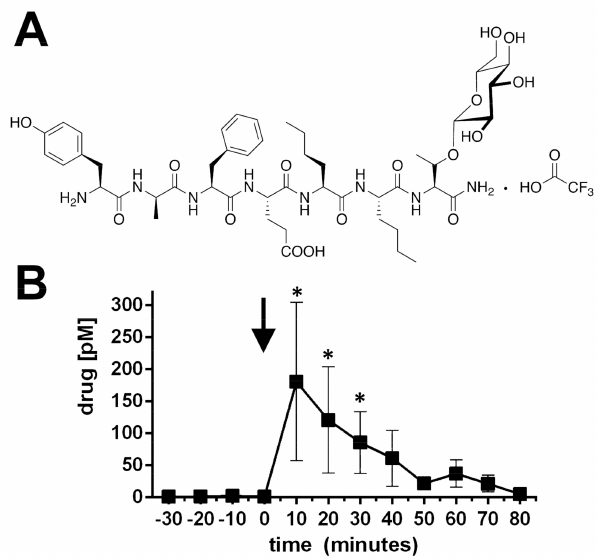
Figure 1. ( A ) Structure of BBI-11008. The native deltorphin sequence YaFEVVG-CONH 2 was modified to produce the glycopeptide YaFENleNleT( β -D-Glc)-CONH 2 , where the two L-valine residues have been replaced with L-nor-leucines (Nle), and the terminal glycine has been replaced with the glucoside of L-threonine. Several related glycopeptide structures were screened for